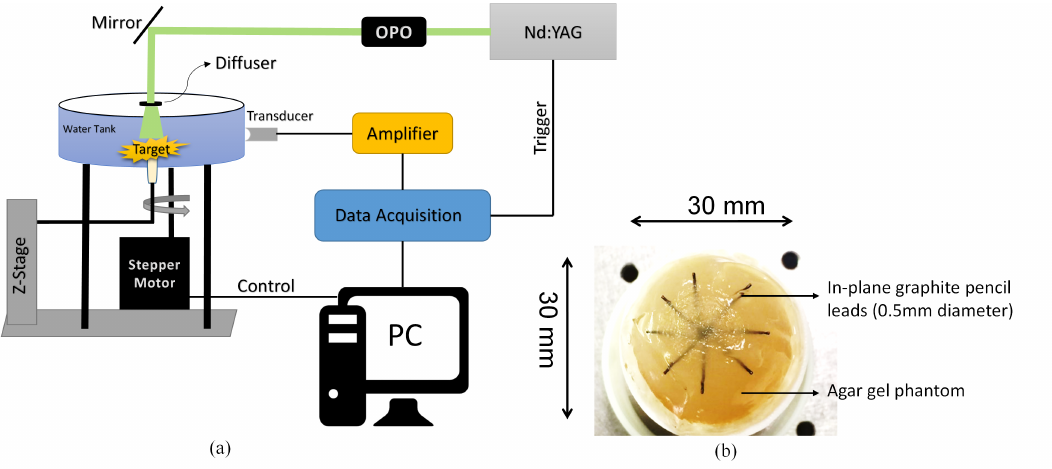
Figure 2. ( a ) Schematic of our PACT system; ( b ) gel phantom with eight 0.5 mm pencil